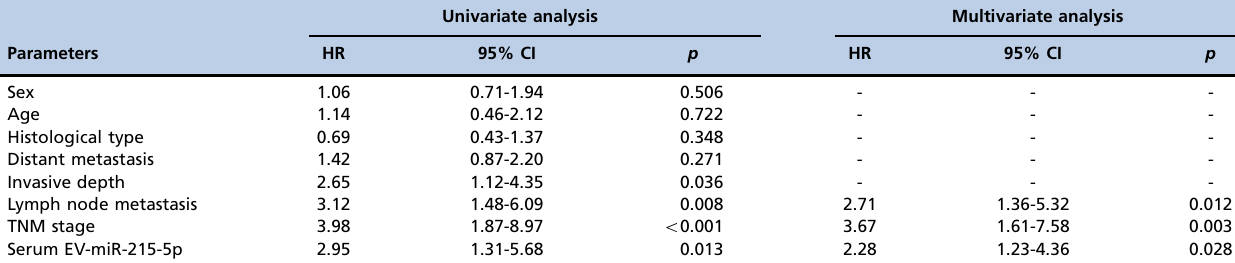
Table 2 - Univariate and multivariate analysis to identify an association between clinical parameters and OS of GC patients.